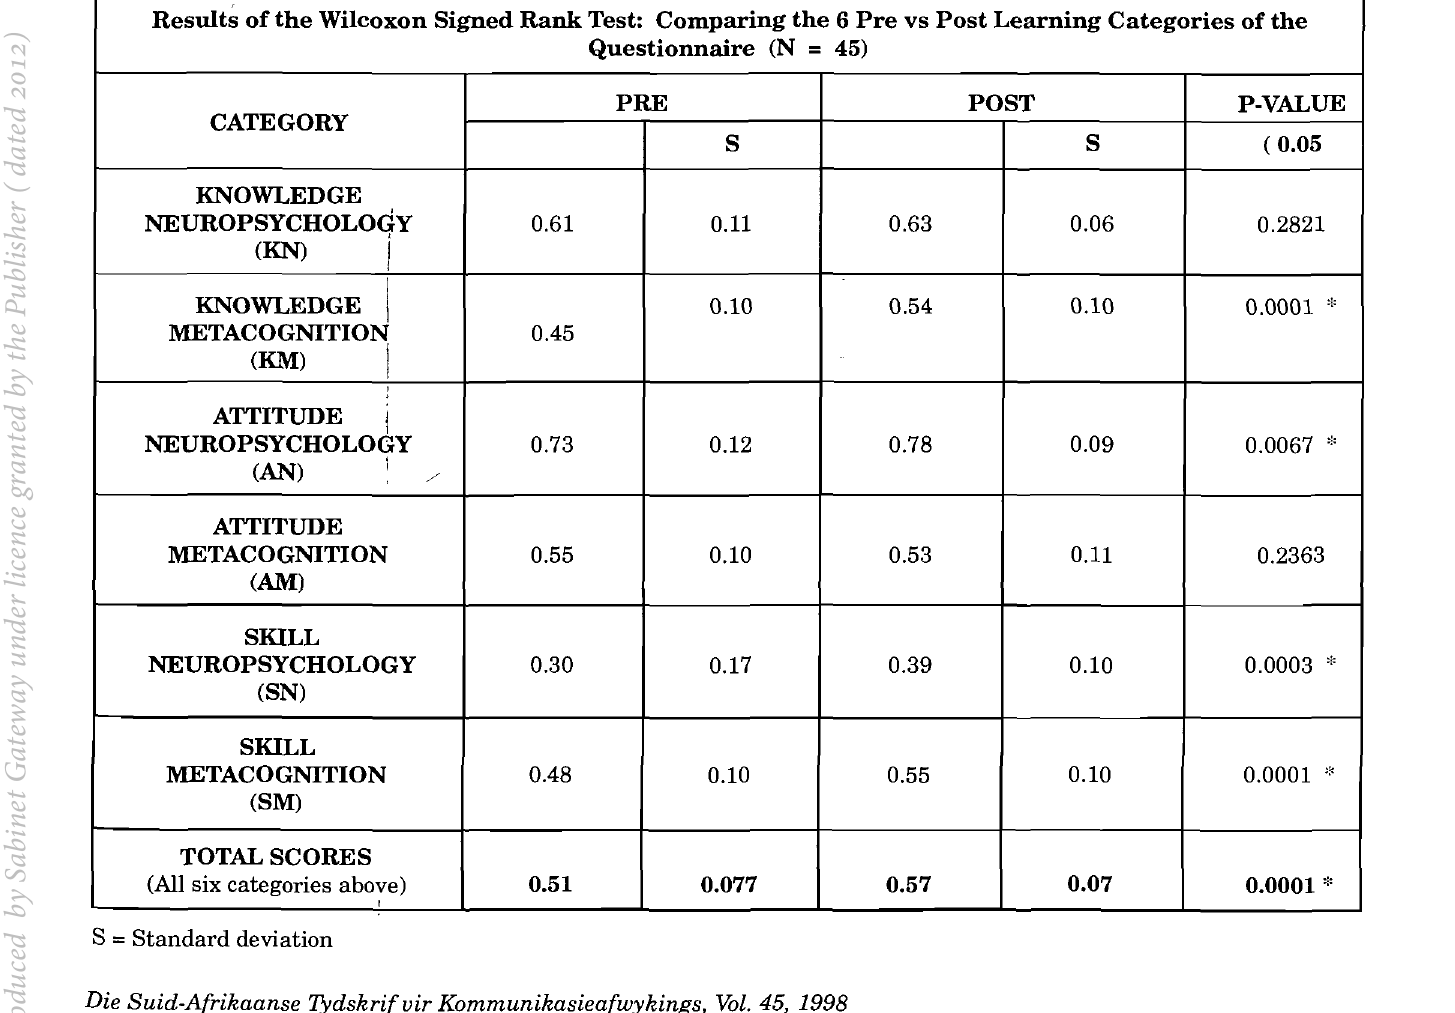
FIGURE 2: Schematic layout of the order of the gen eral procedure of the experiment TABLE 1 : The change in knowledge, attitude and skills regarding the geodesic principles of the MMA Results of the Wilcoxon Signed Rank Test: Comparing the 6 Pre vs Post Learning Categories of